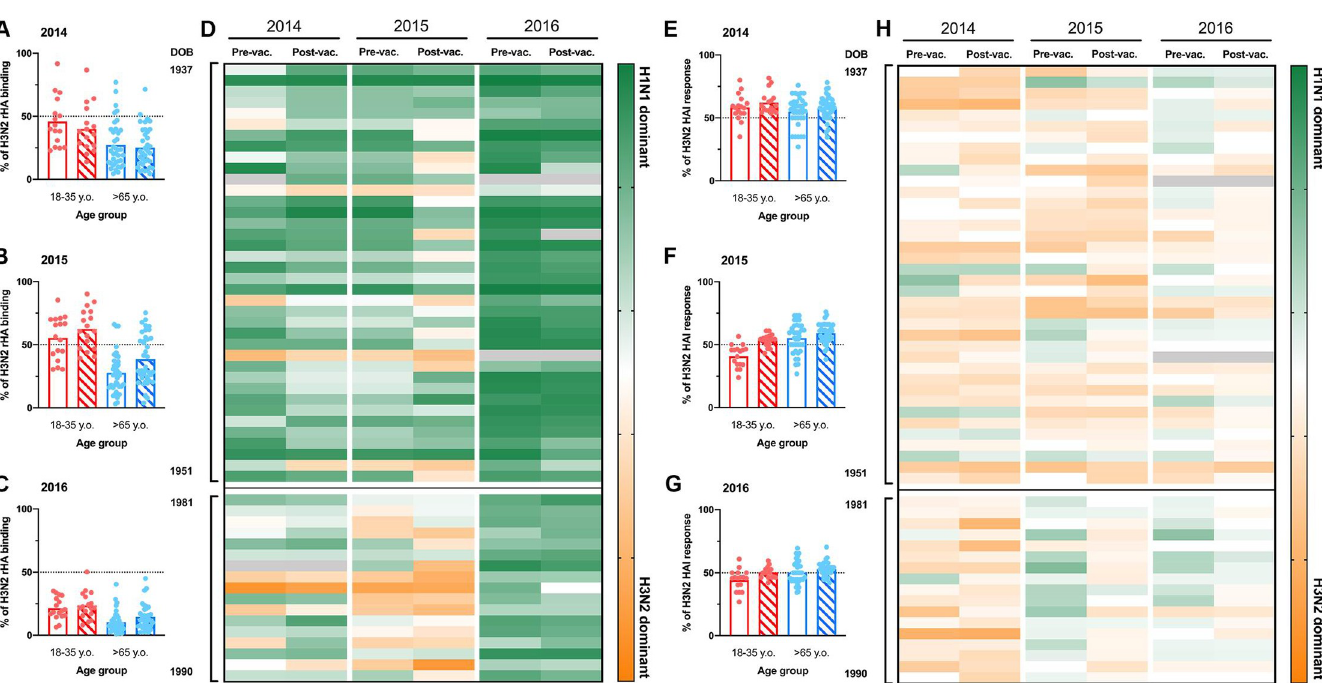
Fig 2. H3N2 vaccine immunogenicity during recurrent vaccination. A-C) Percentage of H3N2 rHA-binding relative to the total serum IgG antibodies against IAV vaccine strains of 50 participants (16 young adult and 36 elderly) in 2014 (A), 2015 (B) and 2016 (C). The dashed-line represents the hypothetical balanced response to both IAV (H1N1 and H3N2) vaccine components. D) IAV subtype immunodominance, based in total rHA-reactive antibodies, in 50 participants organized by age (oldest to youngest from top to bottom) vaccinated for three consecutive years. Dark green represents 100% rHA binding to H1N1 vaccine component. Bright orange represents 100% rHA binding to H3N2 vaccine component. E-G) Percentage of serum HAI activity against the H3N2 vaccine strain relative to total serological HAI activity against IAV vaccine components of 50 participants (16 young adult and 36 elderly) in 2014 (E), 2015 (F) and 2016 (G). The dashed-line represents the hypothetical balanced response to both IAV (H1N1 and H3N2) vaccine components. D) IAV subtype immunodominance, based in serological HAI activity, in 50 participants organized by age (oldest to youngest from top to bottom) vaccinated for three consecutive years. Dark green represents 100% HAI titer response to H1N1 vaccine component. Bright orange represents 100% HAI titer responses to H3N2 vaccine component. Gray boxes represent missing values.